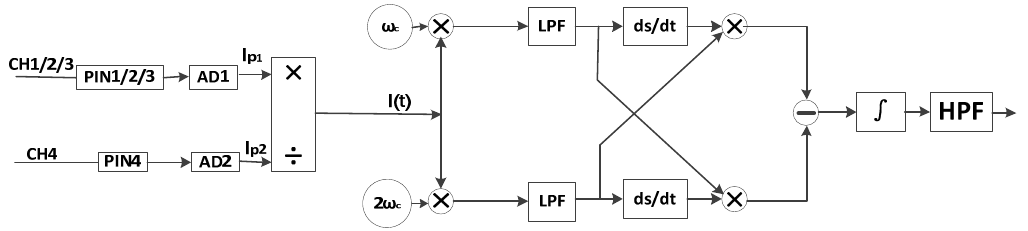
Figure 2. Differential cross multiplication demodulation. PIN1/2/34: photodetector of channel 1/2/3/4; AD1/2: analog to digital convert module; I(t): the interferometric signal; ω c : Cosine signal with frequency of ω c ; 2 ω c : Cosine signal with frequency of 2 ω c ; LPF: low pass filter; ds/dt: differential operation; ∫ : integral operation; HPF: high pass filter.